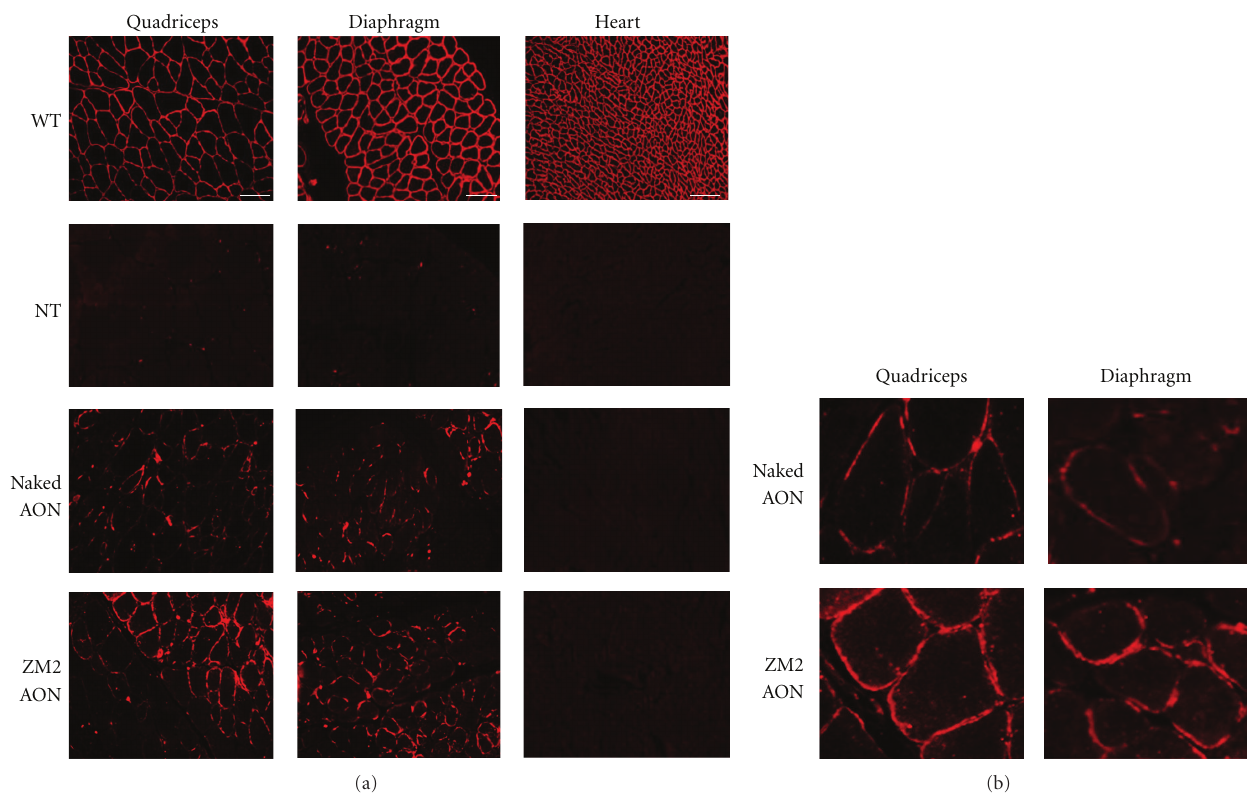
Figure 2: Immunofluorescence analysis. (a) Restored dystrophin is detectable and correctly expressed at the membrane of muscle fibres (quadriceps and diaphragm) from ZM2–AON-treated mdx mice. Traces are also visible in skeletal muscles from naked AON-treated mice, although the distribution at the sarcolemma is not continuous and very faint. Cardiac muscles were found to be negative for restored dystrophin. (Scale bar = 100 μ m in quadriceps, 50 μ m in diaphragms, 25 μ m in heart). (b) Here are represented some enlarged details of immunofluorescence images that highlight the di ff erent expression patterns of rescued dystrophin in the quadriceps and diaphragm of ZM2–AON- and naked AON-treated mdx mice. These images show both a brighter dystrophin labelling and a more continuous distribution along the fibre membranes in muscles from ZM2–AON-treated mice (NT, untreated; WT, wild